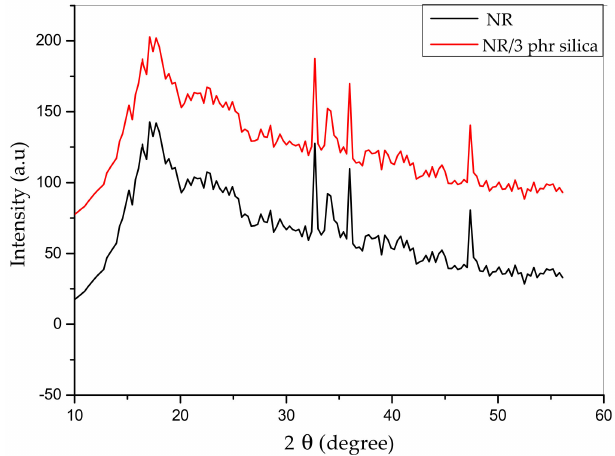
Figure 10. XRD spectra of vulcanized NR and NR / 3 phr